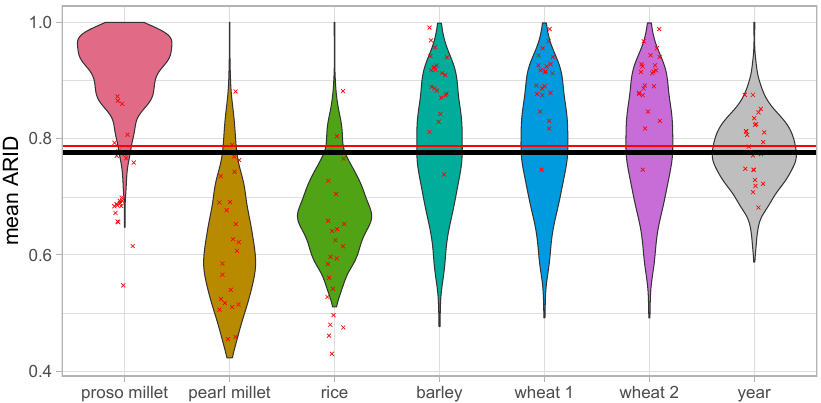
Figure 3. Mean ARID during each crop growing season and the entire harvest calendar year, as generated in experiment 0 (red points) and 1 (distribution shapes). The strong horizontal lines mark the average value of annual means for each dataset (red: experiment 0; black: experiment